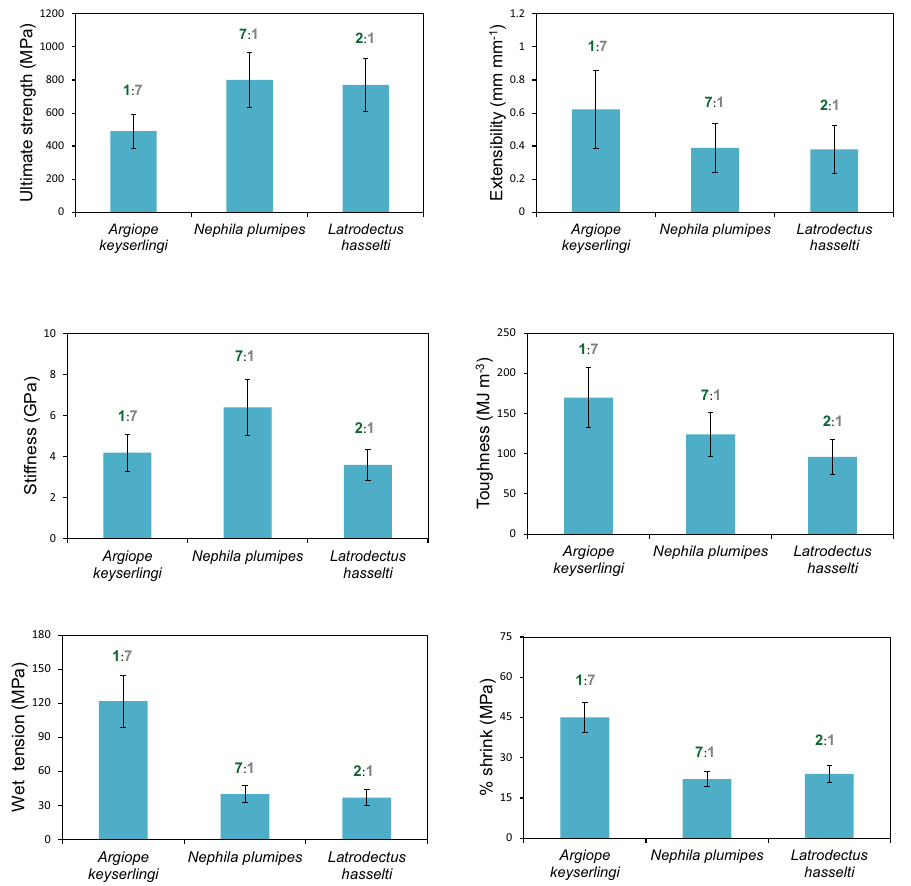
Figure 2. Comparisons of the ultimate strength, extensibility, stiffness and toughness of native silks, and wet tension and percent shrink of supercontracted silks of L. hasselti , A. keyserlingi and N. plumpes dragline silks taken from spiders collected in May. Numbers associated with the respective species’ bars show the β -sheets (green): 3,10 helices/random coil (grey) ratios ascertained by ssNMR (see Figure 1).